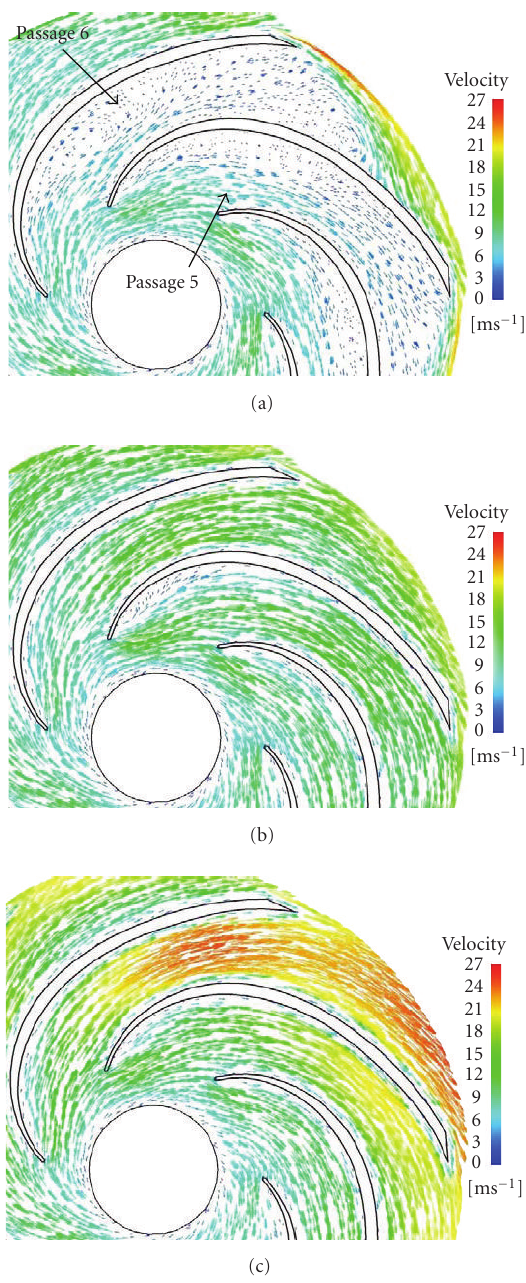
Figure 5: Relative velocity inside impeller passage 5 and 6. (a) O ff - design point, Q = 0.43 Q design . (b) Design point, Q design . (c) O ff - design point, Q = 1.45 Q design